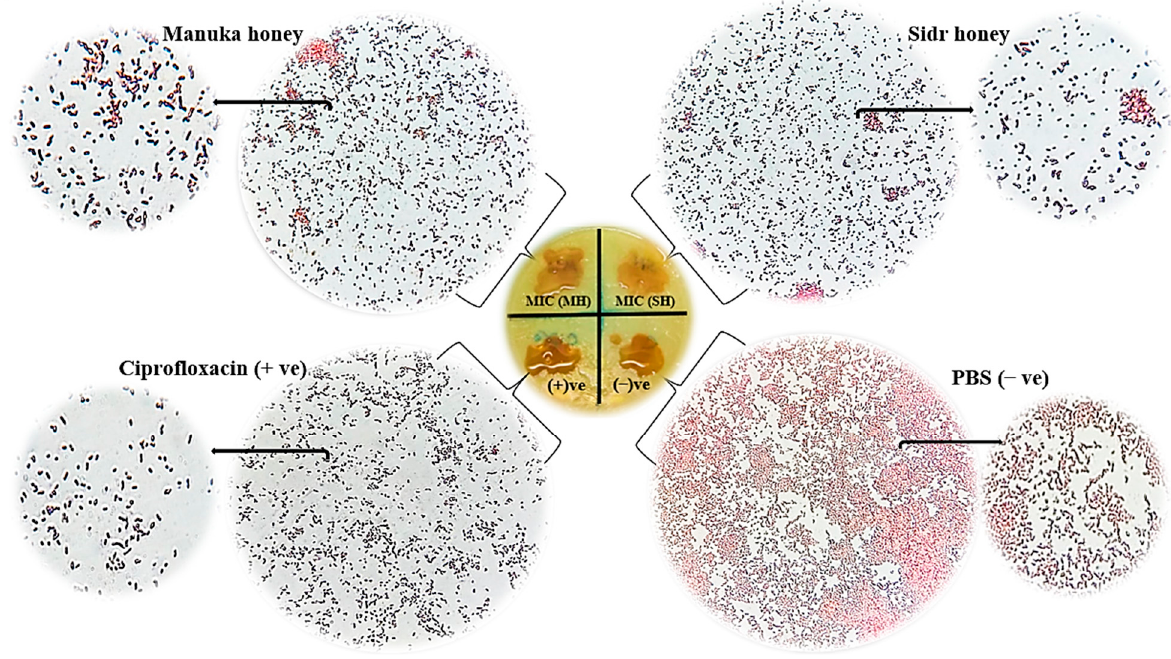
Figure 5. Effect of Sidr honey (SH) and Manuka honey (MH), (+ve): positive control (10 µg/mL Ciprofloxacin), and ( − ve): negative control (PBS) on DNA damage of Escherichia